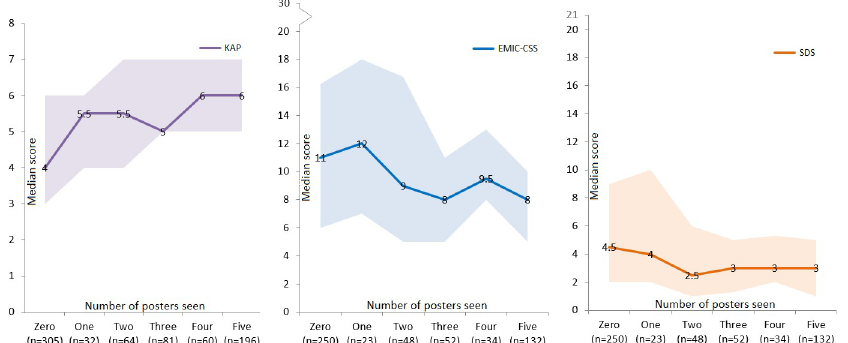
Fig 3. An overview of the number of posters seen and the corresponding median KAP (knowledge, ranging from 0–8 with higher scores denoting better knowledge), EMIC-CSS (community attitudes, ranging from 0–30 with higher scores denoting more negative attitudes) and SDS scores (personal attitudes, ranging from 0–21 with higher scores denoting more negative attitudes) and corresponding first and third quartiles. Please note that the graphs have different